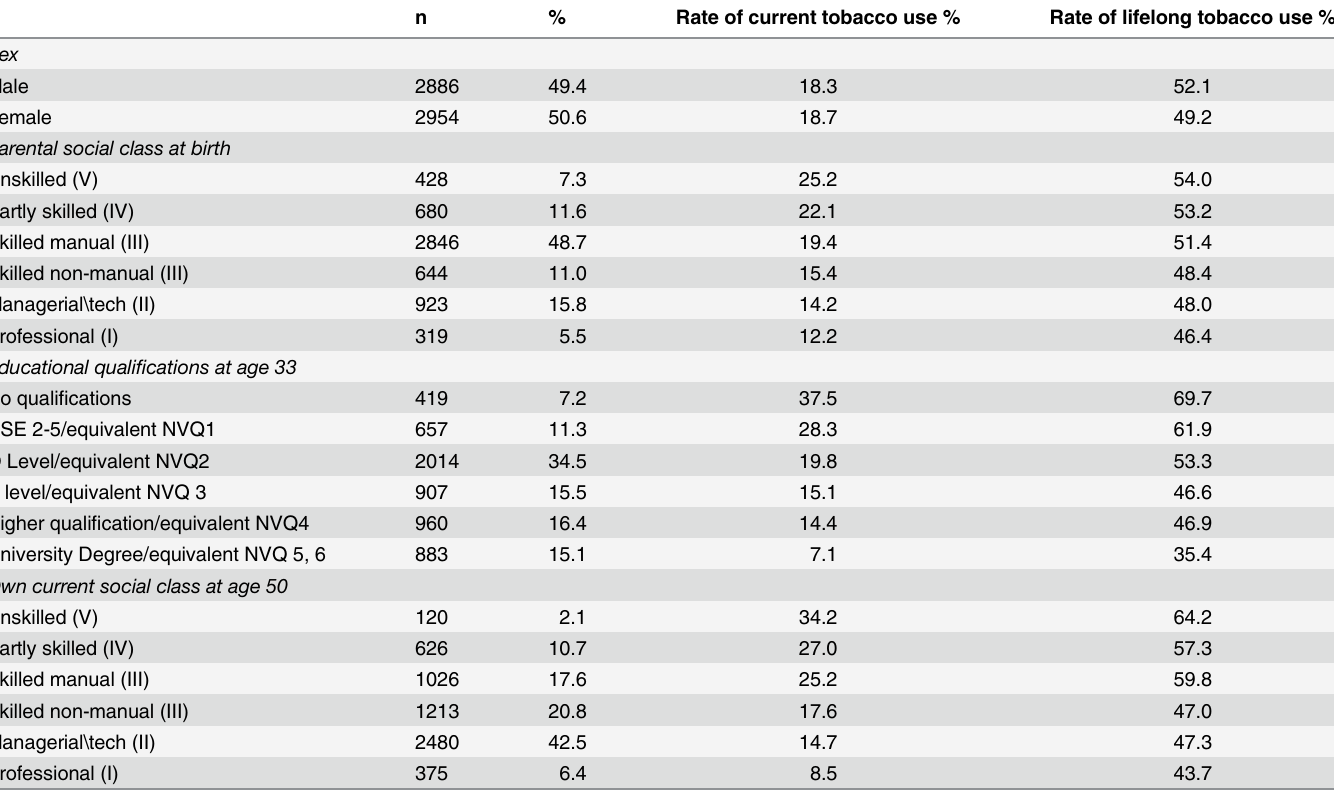
Table 1. Social and demographic characteristics of the study population and the rate of current and lifelong tobacco use. n